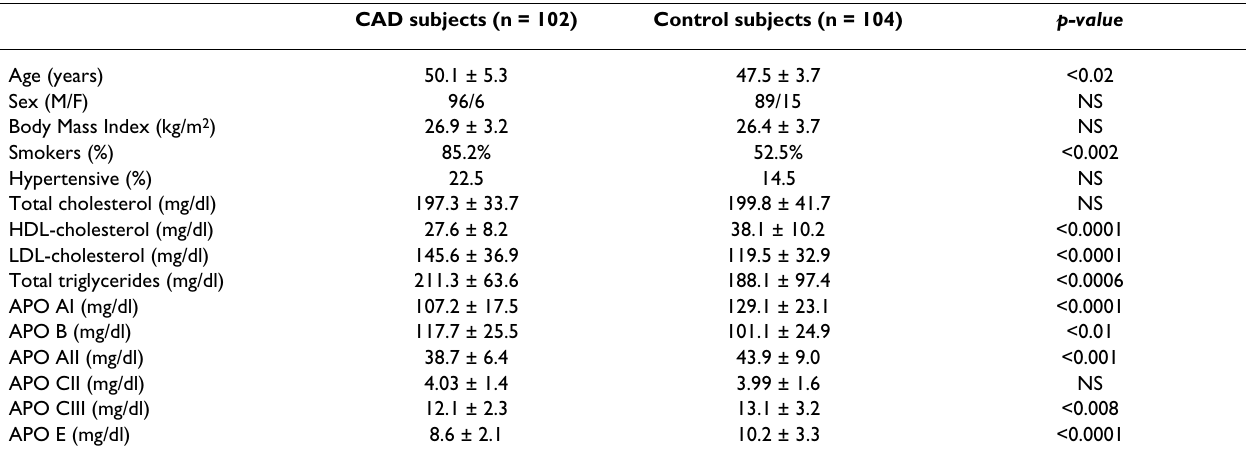
Table 1: Clinical and biochemical characteristics of study